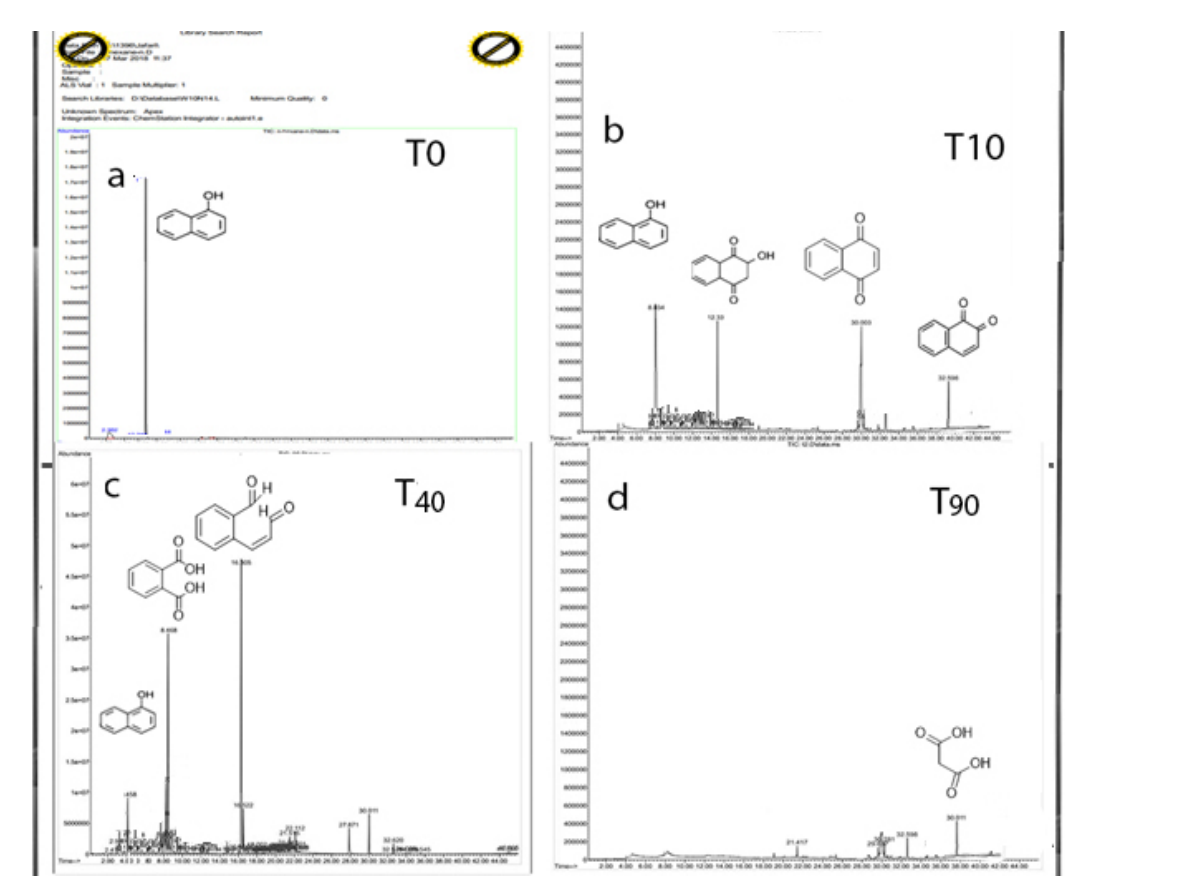
/SSA catalyst during irradiation 2